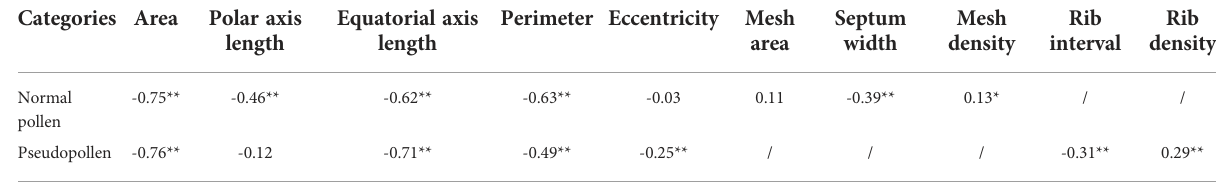
TABLE 2 Correlation between micro-characteristics of pollens (normal pollen and pseudopollen) and species. Categories